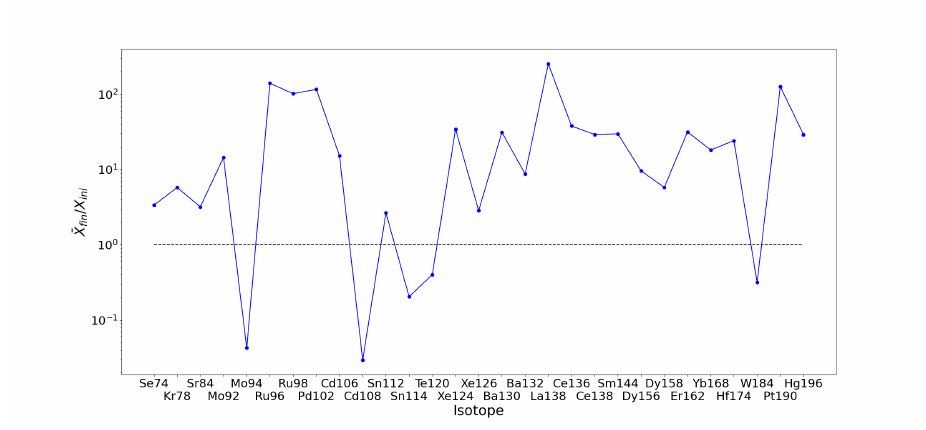
Figure 4. Average overproduction of p-nuclides for an approximated accretion disk composed of eight trajectories modelling accretion around a 1 . 5M ⊙ neutron star at an accretion rate of 8 × 10 − 5 M ⊙ s − 1